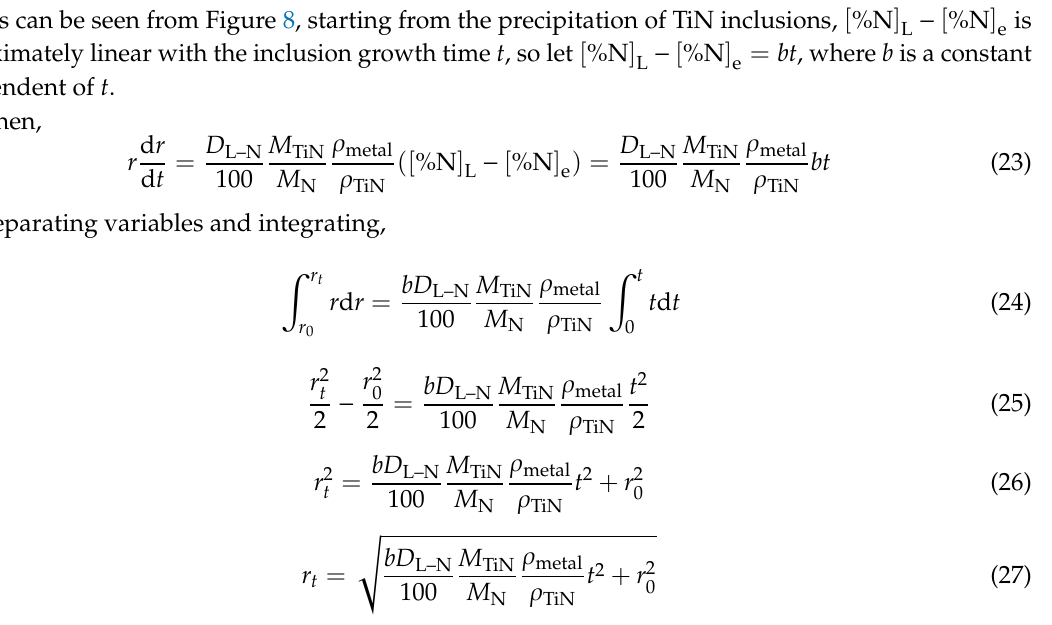
Figure 8. The relationship between [ %N ] L − [ %N ] e and the solidification time t f .